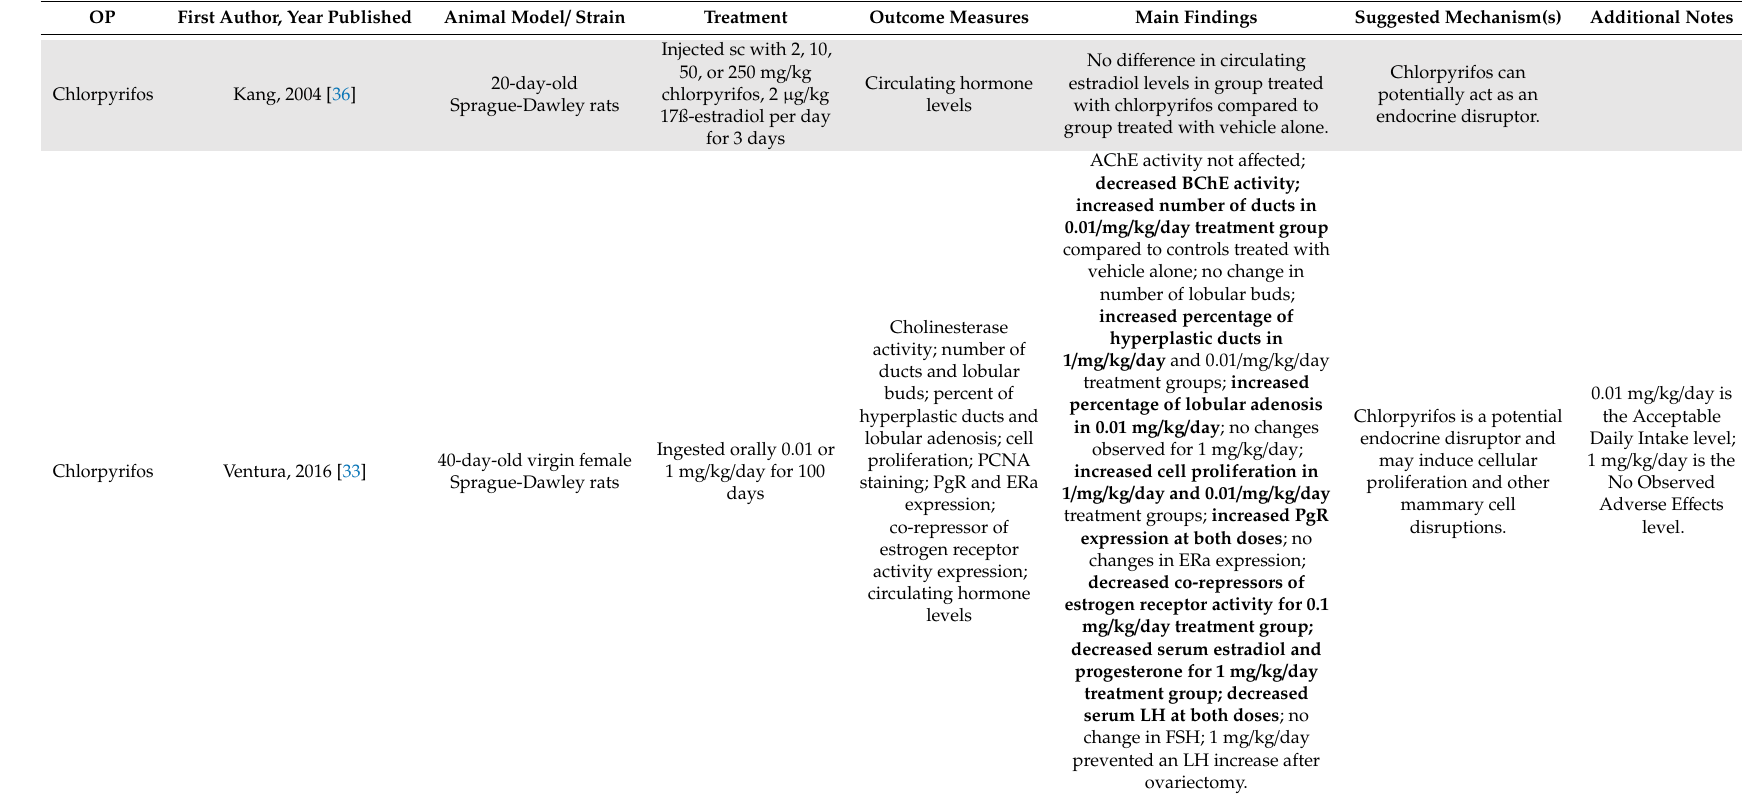
Table 2. Summary of animal studies on organophosphate pesticides and mammary gland